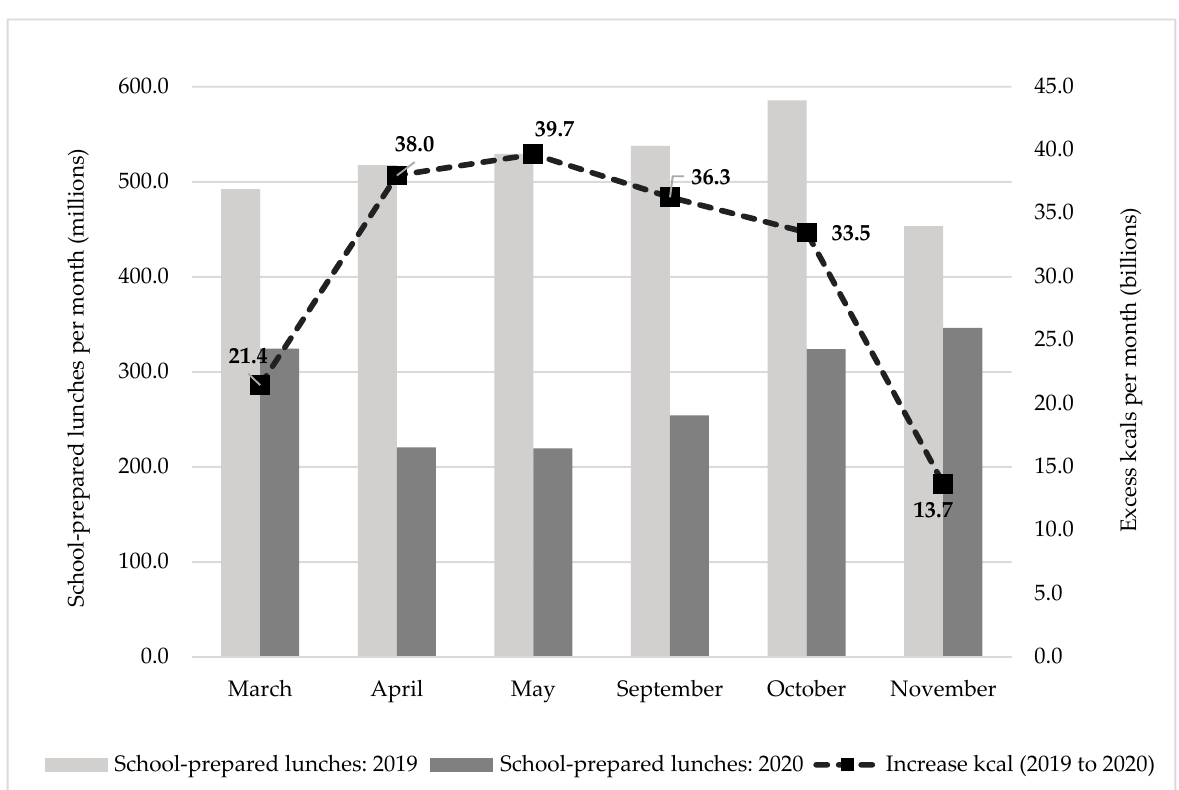
Figure 1. Total monthly lunchtime meals served and excess calories consumed by National School